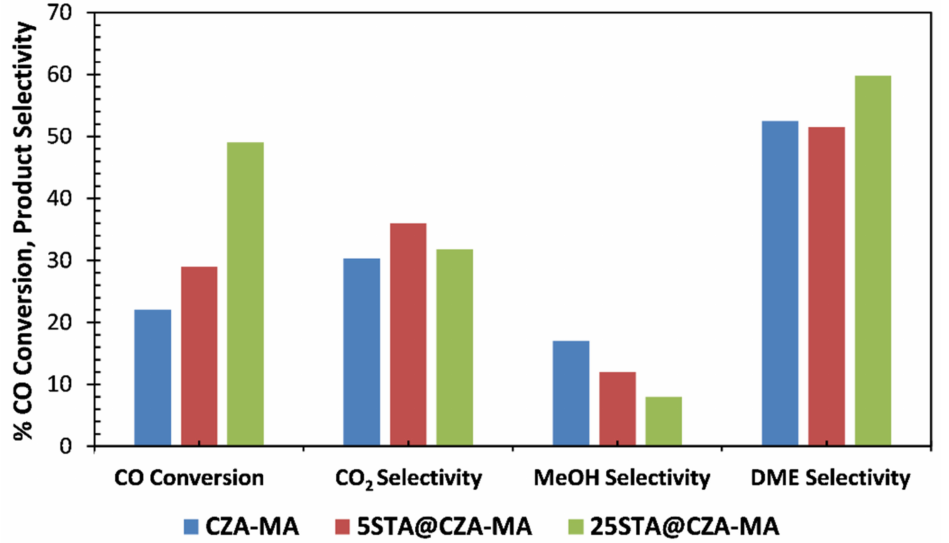
Figure 8. CO conversion and Product distribution of STA incorporated core-shell catalysts (T = 275 ◦ C; P = 50 bar; CO/H 2 :1/1 as feed stream; space-time of 0.72 s.gcat/mL).